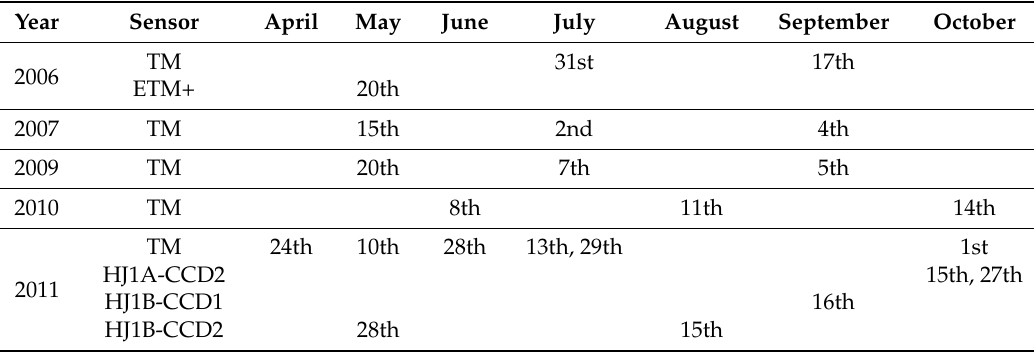
Table 2. The dates of Landsat TM/ETM+ and HJ CCD images (in Manas).